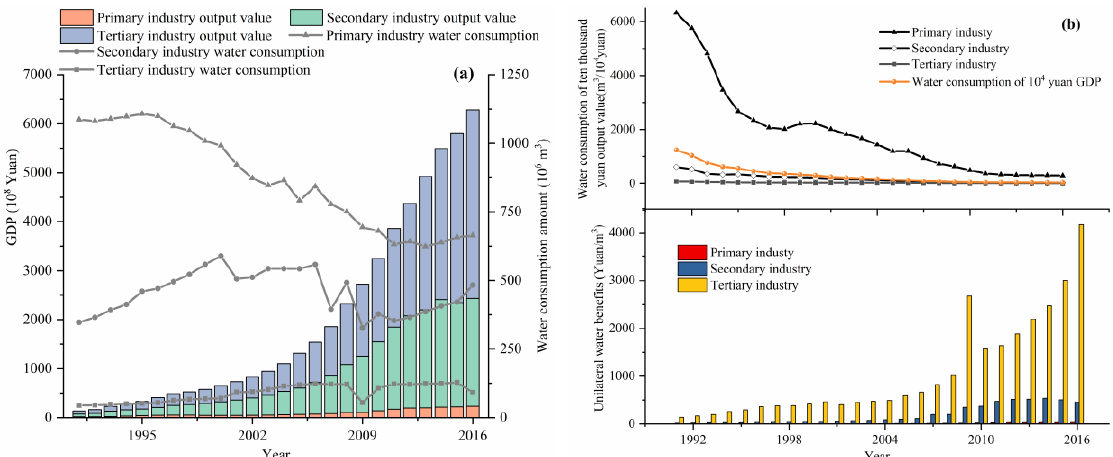
Figure 5. Changes in the industrial structure and the water utilization of Xi’an city. ( a ) illustrates the relationship between the three industrial water consumption and their output value; ( b ) illustrates the variations of water consumption of ten thousand yuan output value of three industries and GDP and unilateral water benefits of three industries.